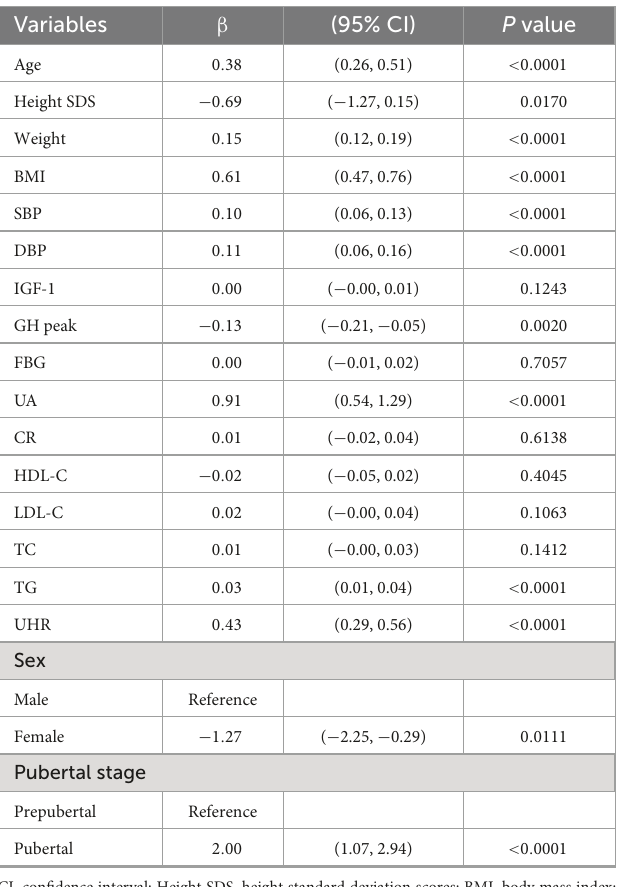
TABLE 2 Factors correlated with ALT (U/L) in the